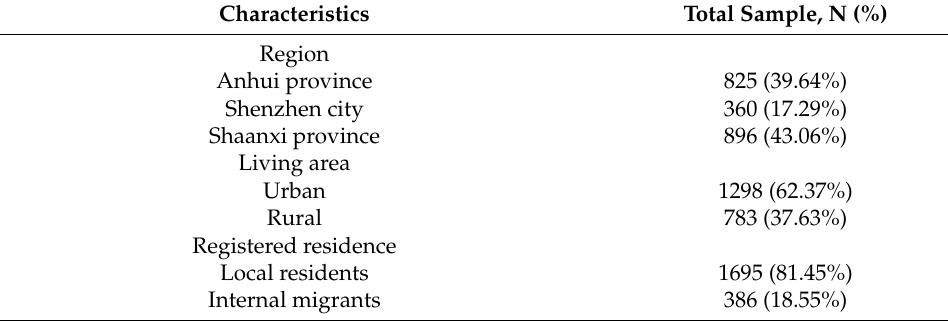
Table A2. Respondent Characteristics, N